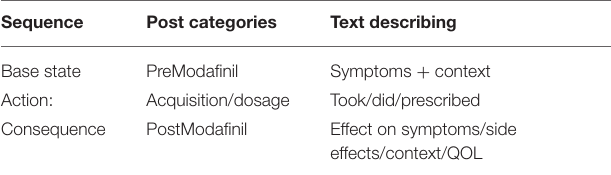
TABLE 1 | Using categories to identify causal text and perceived